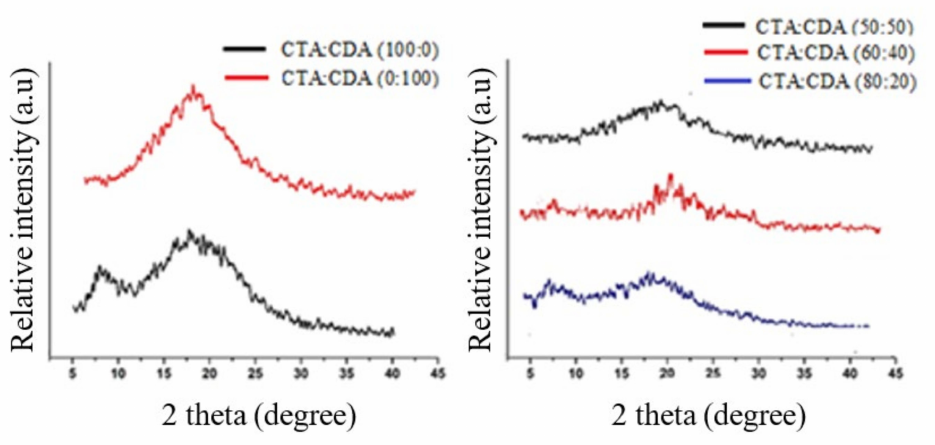
Figure 3. XRD analysis of fabricated